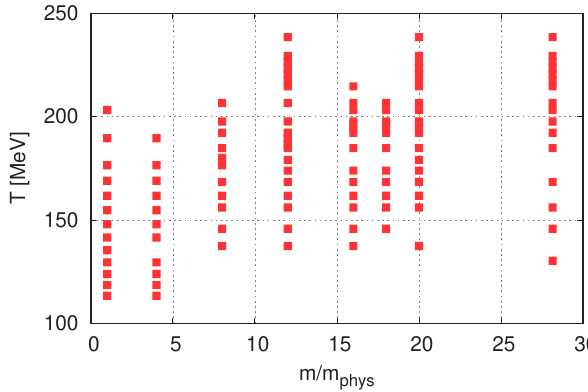
Figure 1 . The points on the T (cid:0) m plane used for con(cid:12)guration generation in this